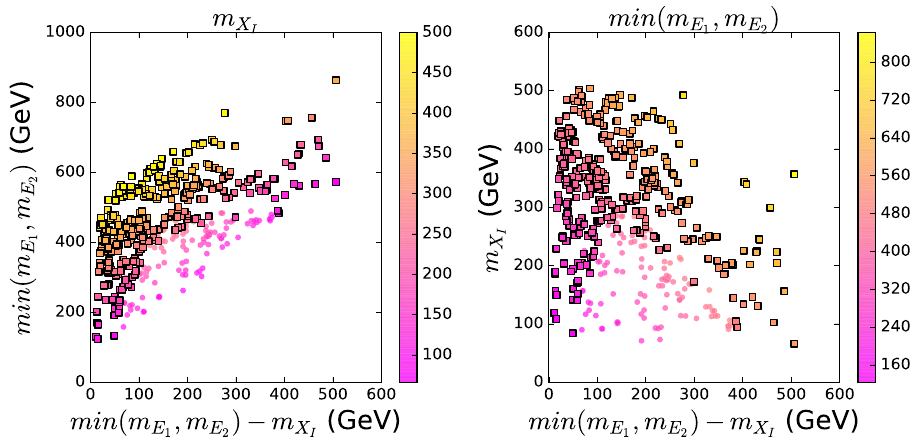
Fig. 7 For the scenario of / m < 1 . 15 and 1 < m X X I R m Z (cid:2) ( m S ) > m X , all samples R satisfy the constraints of “pre ( g − 2 ) μ ”, the diphoton signal data of the 125 GeV Higgs, the muon g − 2 anomaly, and the DM relic density. The squares and circles are allowed and excluded by the direct searches for 2 (cid:3) + E miss at the LHC. The T varying colors in each panel indicate the values of m X and I , m ) , min ( m E E 2 1